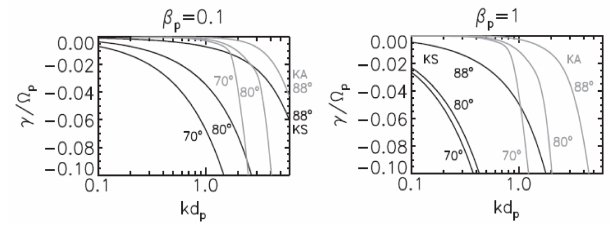
Figure 13. Damping rates ( γ ) of very obliquely propagating kinetic wave modes, the kinetic Alfvén wave (KAW) and kinetic slow mag- netoacoustic wave (KSW) after Narita and Marsch (2015). Both are shown versus wave number ( k ) for various propagation angles with respect to the mean magnetic field. The units are the proton gy- rofrequency (cid:127) p and inertial length d p = V A /(cid:127) . Left panel is for β p = 0 . 1 and right for β p = 1 . 0. Note that substantial damping sets in at longer wavelength for the KSW than KAW. Thus the kinetic slow wave is more prone to Landau damping for a wider angular